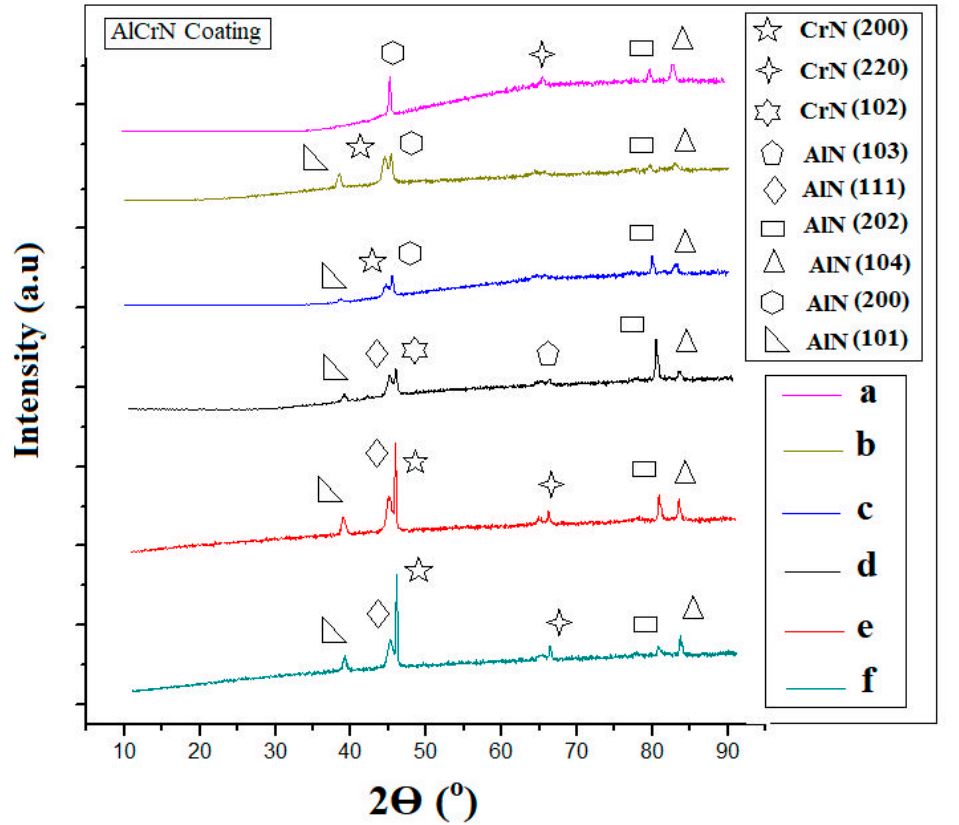
Figure 8. XRD patterns for the AlCrN coated samples. ( a ) Fe, ( b ) Fe–2Cu, ( c ) Fe–2Cu–0.8C, ( d ) Fe–2Cu–0.8C–0.2Mo, ( e ) Fe–2Cu–0.8C–0.4Mo, and ( f )